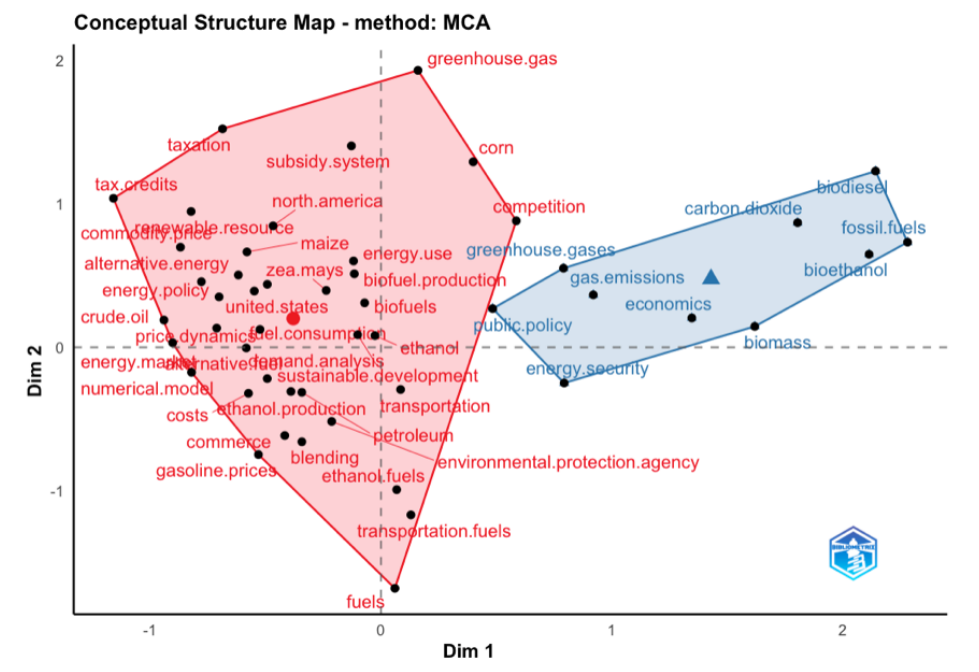
Figure 12. Conceptual structure